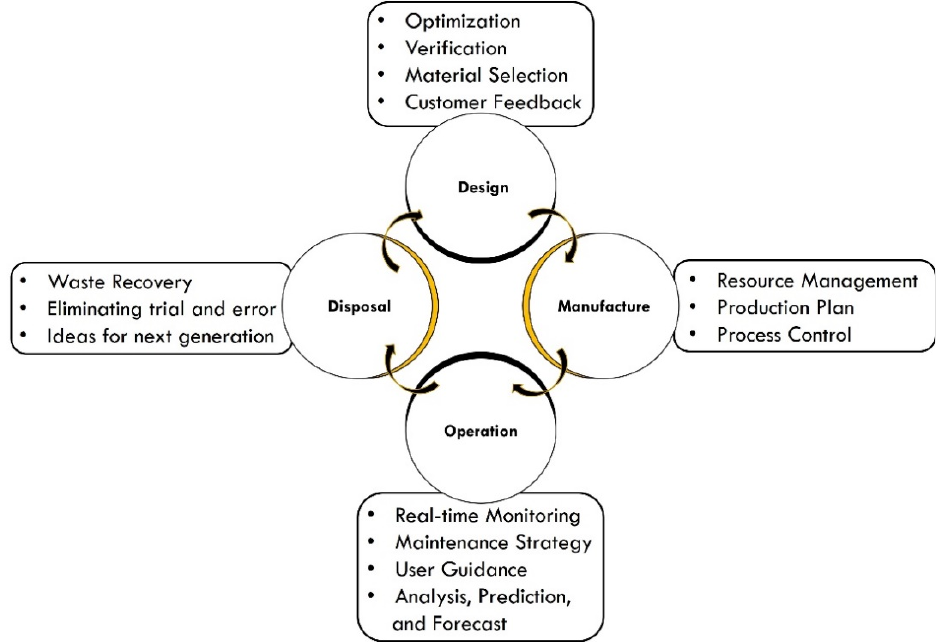
Figure 3. DT’s applications throughout a product’s lifecycle.